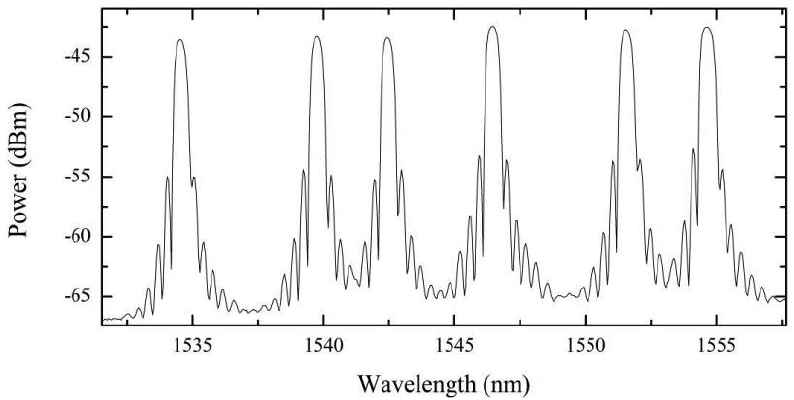
Figure 4. Optical reflection spectrum of the temperature sensor with six